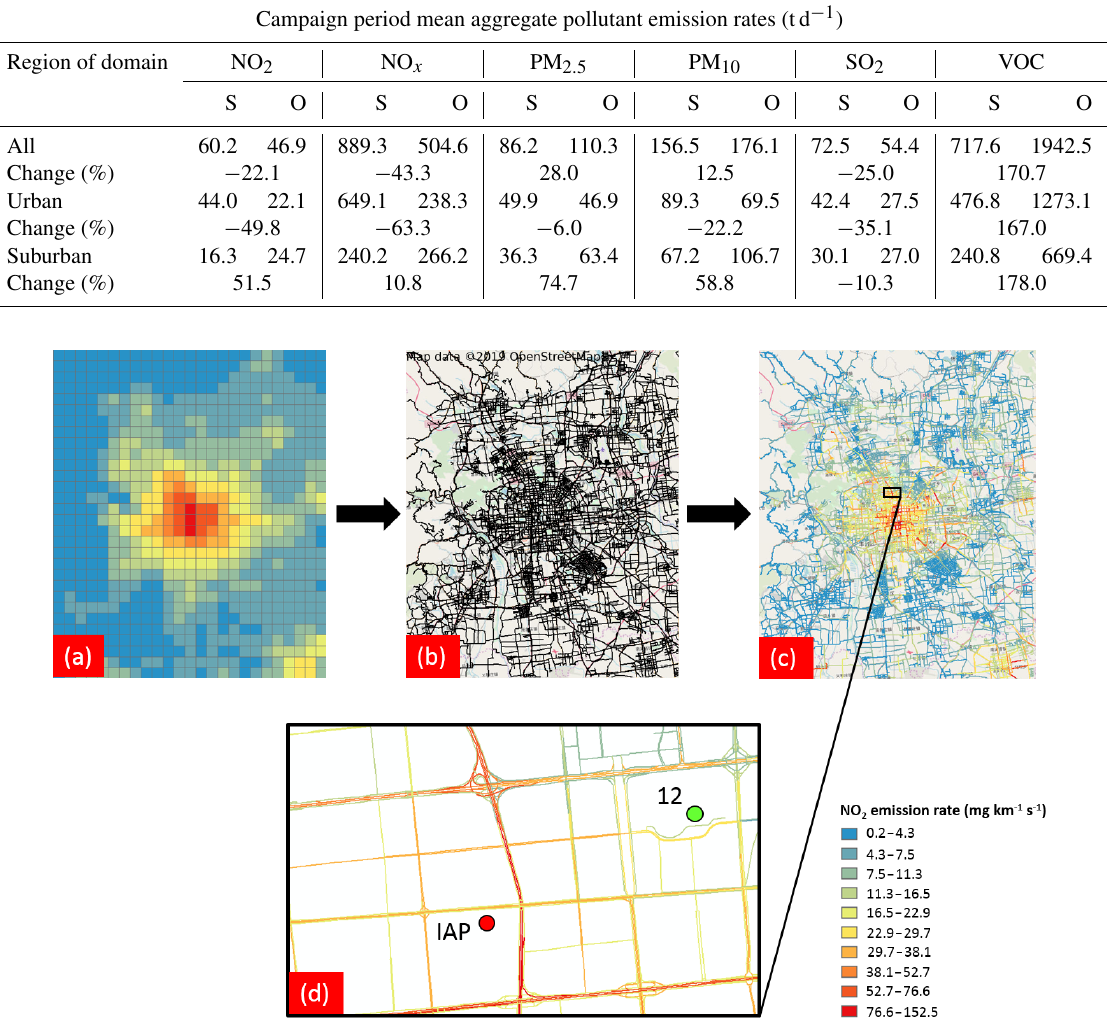
Table 2. Campaign period mean MEIC Std (S) and MEIC Opt (O) pollutant species emissions (td − 1 ) aggregated across all, urban and suburban grid cells. Change (%) in emissions between inventories, following optimisation, calculated as (O – S/S) × 100.